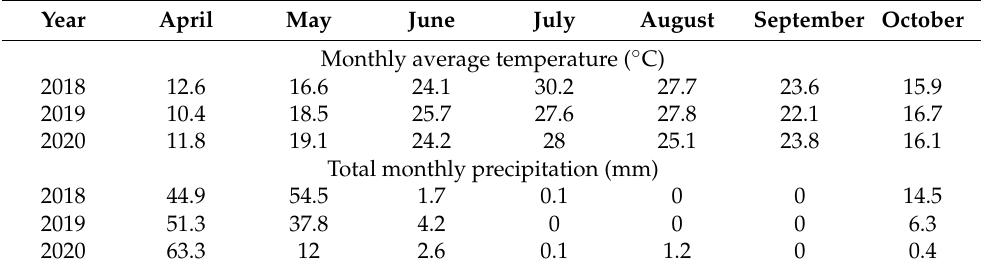
Table 4. Monthly average temperature and total monthly precipitation growing seasons.